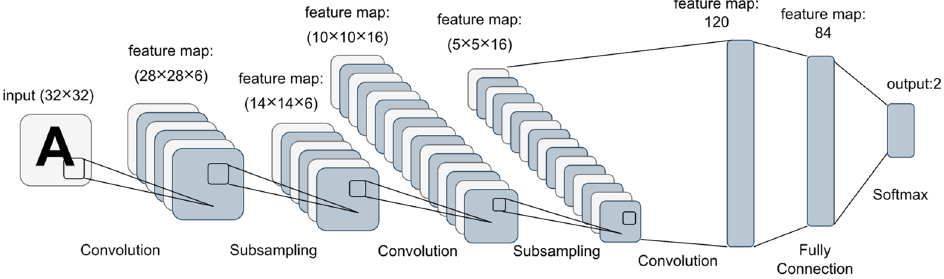
Figure 2. The layer structure of the LeNet architecture (example of CNN-based model).